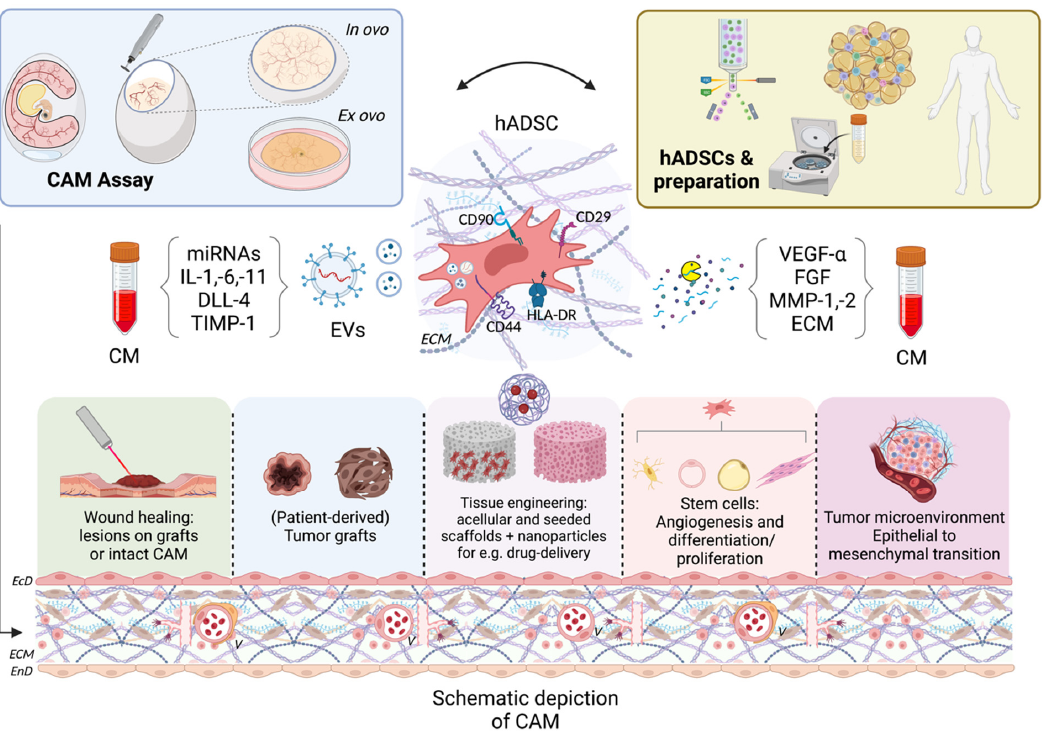
Figure 1. Schematic illustration of existing and potential applications of the chorioallantoic mem- brane (CAM) assay in ADSC research. Cells can be either isolated from human donors or obtained commercially. After a certain pre-treatment they can be grafted onto the available in ovo or ex ovo CAM models in order to investigate wound healing, tumor (anti-)angiogenesis and its microen- vironment, (bio-)scaffolds, and stem cell proliferation and/or differentiation. Therefore, a human adipose-tissue-derived stem cell (hADSC) exemplarily positive for cluster of differentiation 29 (CD29), CD44, CD90, and Human Leukocyte Antigen DR isotype (HLA-DR) is depicted with its secretome, i.e., extracellular vesicles (EVs) and paracrine products, e.g., extracellular-matrix (ECM) and matrix metalloproteases (MMPs), which can be isolated and added onto the CAM as a conditioned medium (CM). The CAM structure is depicted with its outer and inner sheeting consisting of ectodermal (EcD) and endodermal epithelium (EnD), respectively. Between those two layers rich extracellular matrix (ECM) with partially spouting vessels (V) is shown. Additional abbreviations: miRNAs—micro ribonucleic acids, IL—interleukin, DLL—Delta-like protein, TIMP—tissue inhibitor of metallopro- teinases, VEGF—vascular endothelial growth factor, FGF—fibroblast growth factor. Created with BioRender.com ® (accessed 7 February